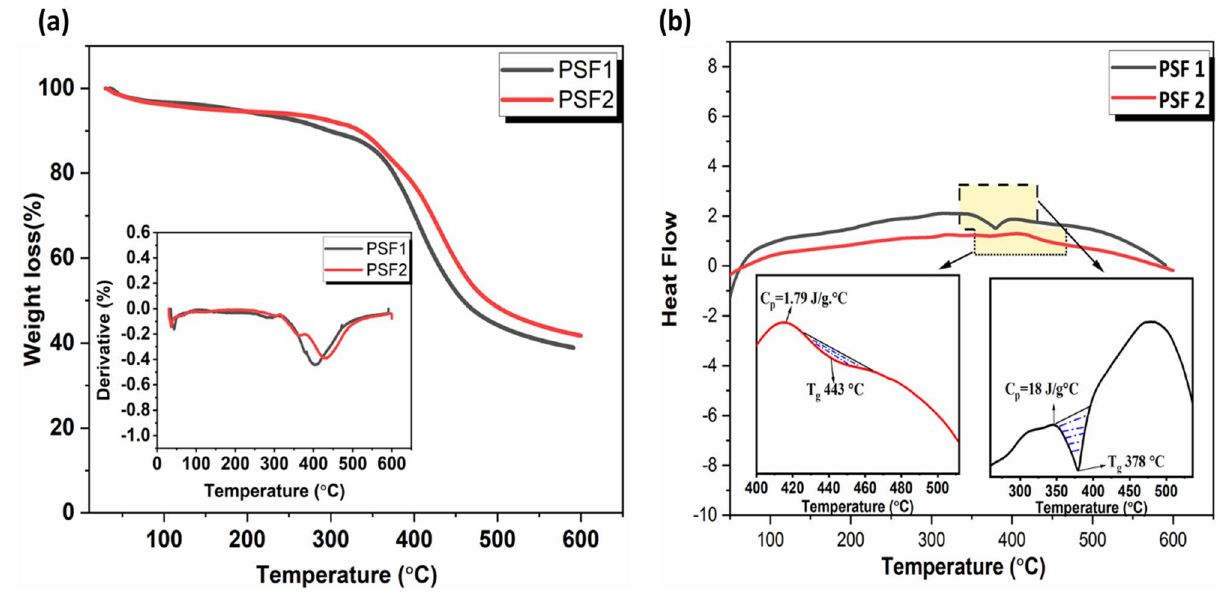
Figure 5. ( a ) TGA and Dr-TGA inset of PSF1 and PSF2 ( b ) DSC of PSF1 and PSF2.